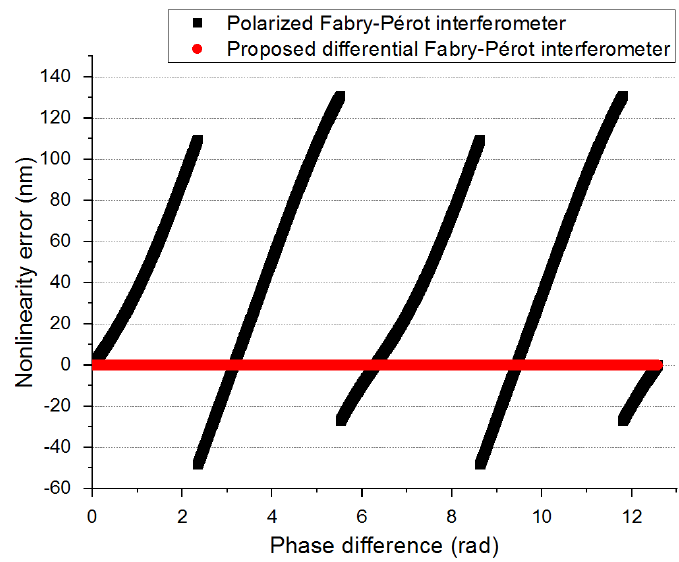
Figure 8. Comparison of nonlinearity error between polarized and proposed differential Fabry–Pérot interferometer.